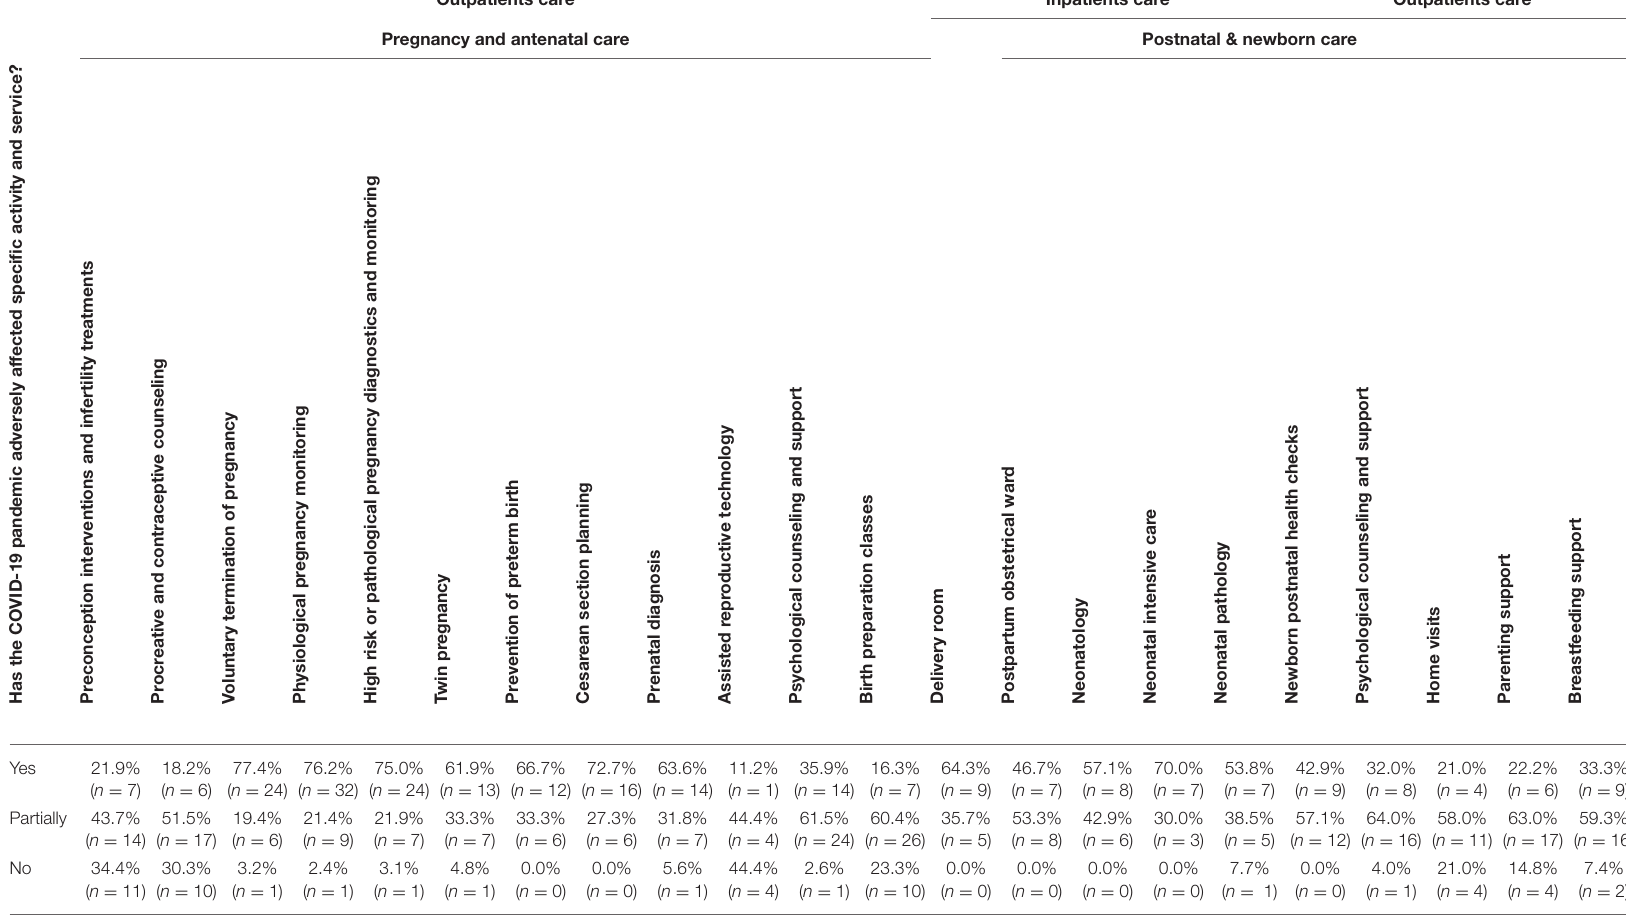
TABLE 2 | Impact on activities and services provided by perinatal healthcare facilities in the Italian national territory. Outpatients care Inpatients care Outpatients